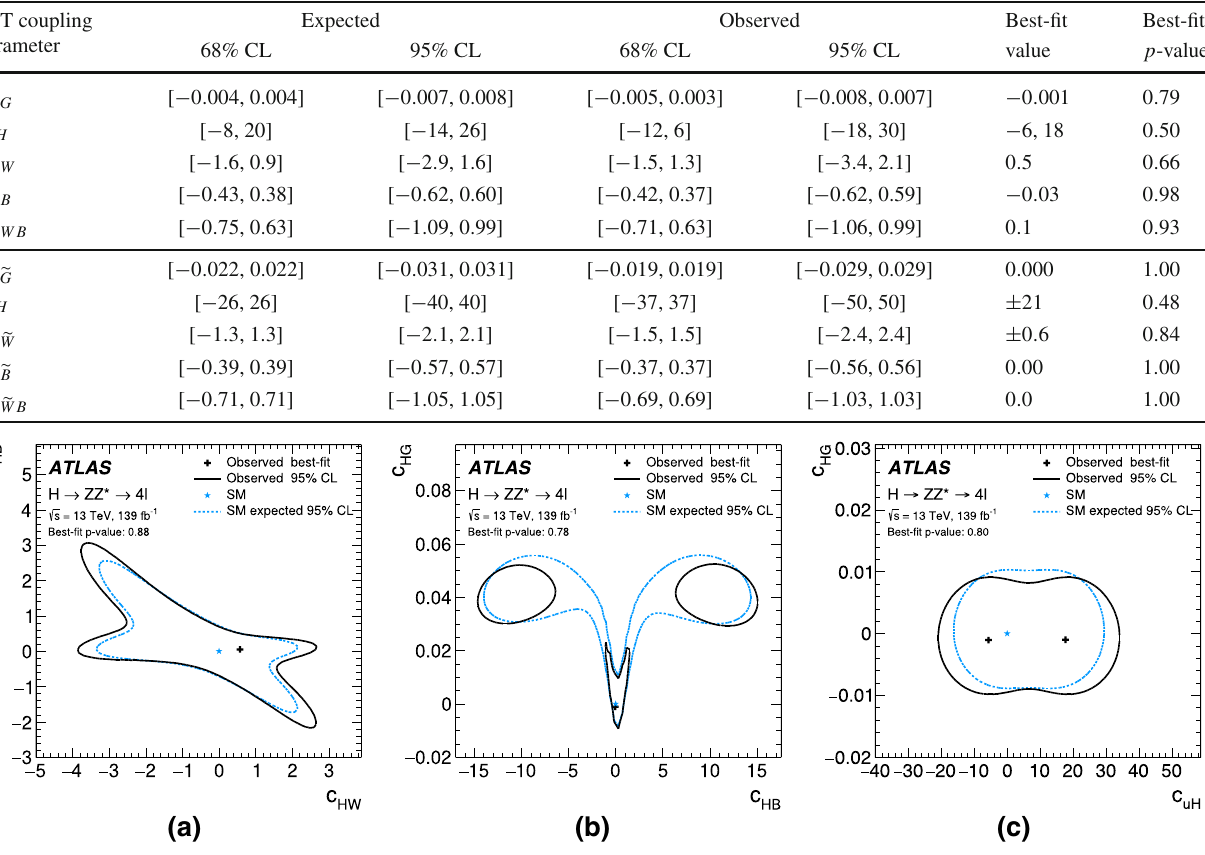
Fig. 17 Expected (dashed line) and observed (full line) 2D-fit like- lihood curves at the 95% CL for the SMEFT Wilson coefficients of CP-even operators at an integrated luminosity of 139 fb − 1 and